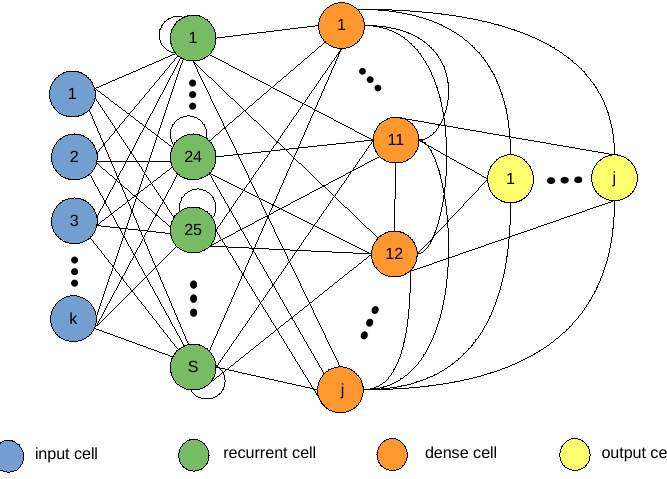
Figure 2. MES-LSTM Architecture